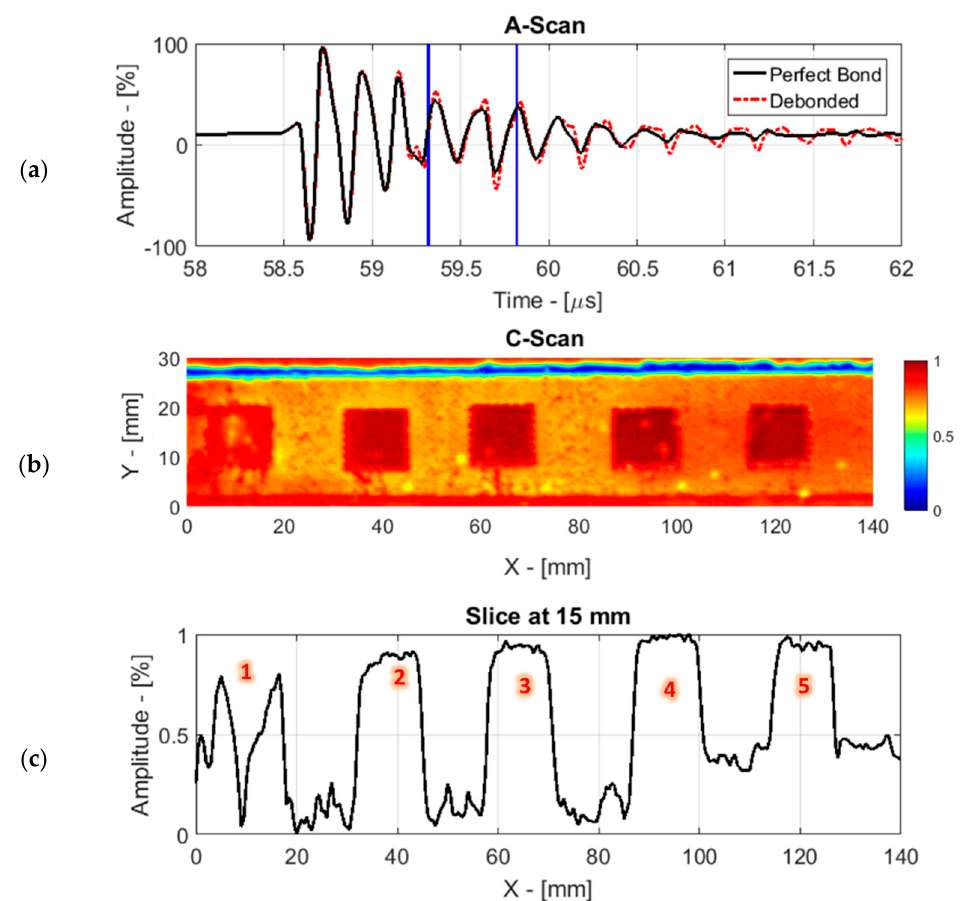
Figure 12. Immersion pulse-echo results: ( a ) A-scan; ( b ) C-scan with the gate at the bonding interface time of flight; ( c ) slice from the middle of the defects.